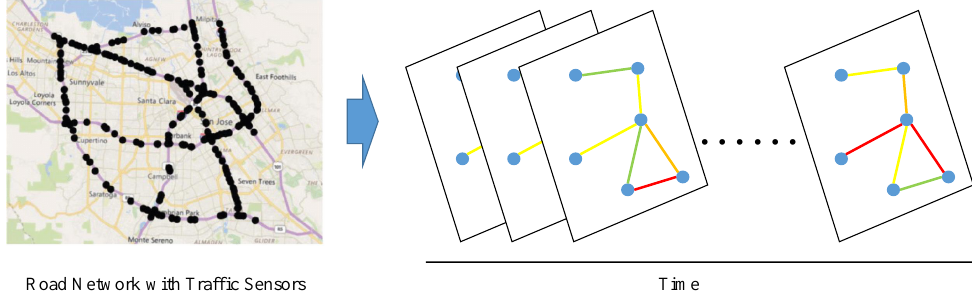
Figure 2. The graph-format traffic forecasting problem